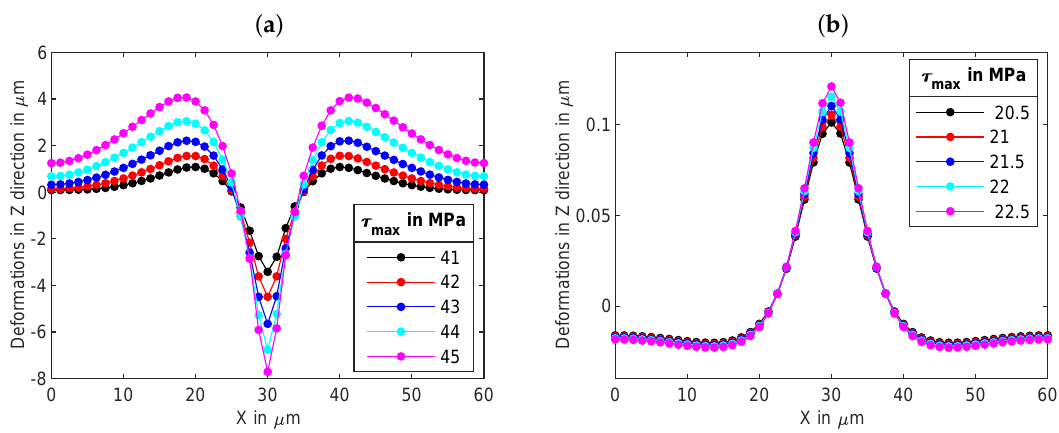
Figure 4. The deformations in z direction for light polarized ( a ) in x direction and ( b ) in y direction at different values of maximal traction shown in the legend. The film dimensions are 0 ≤ x ≤ 60 µ m, 0 ≤ y ≤ 15 µ m, 0 ≤ z ≤ 15 µ m and the beam radius w = 2